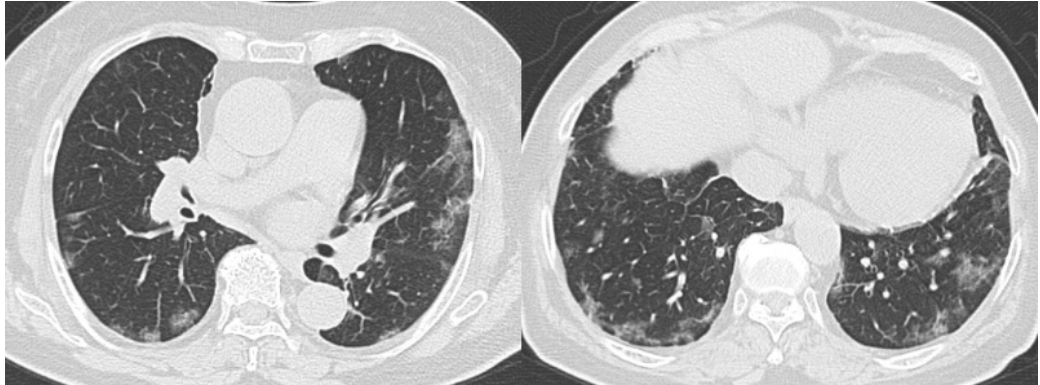
Figure 3. Representative computed tomography (CT) images of COVID-19 pneumonia (Case 1). Fifty-two-year-old man. The CT images show multifocal bilateral, peripheral/subpleural ground-glass opacities with consolidations. RT-PCR was positive for SARS-CoV-2. All readers diagnosed it as Category 5. COVID-19, coronavirus disease 2019; CT, computed tomography; RT-PCR, reverse transcription-polymerase chain reaction; SARS-CoV-2, severe acute respiratory syndrome coronavirus 2. CO-RADS, COVID-19 Reporting and Data System; CT, computed tomography; P, positive; N, negative.